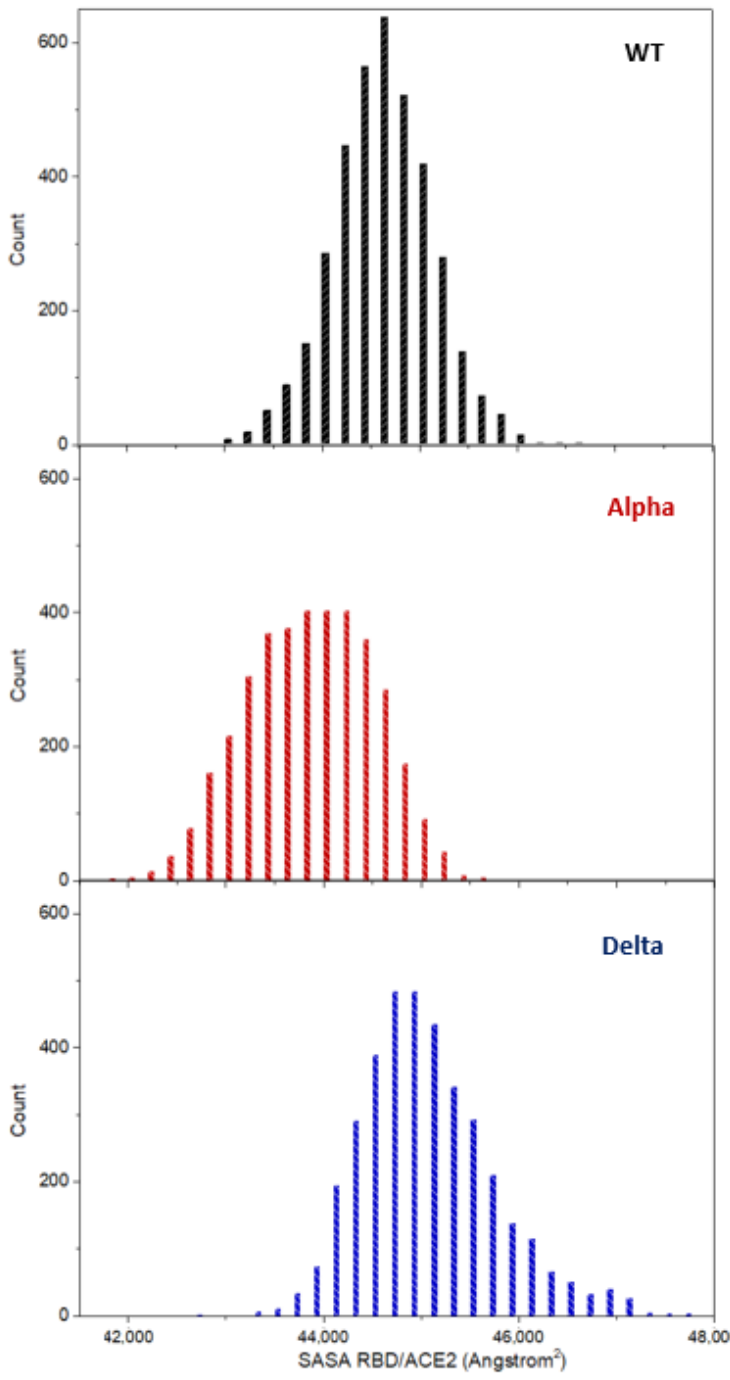
Figure 4. Histogram of the SASA values computed along the simulation time. The data of the three runs of each ACE2/RBD complex under study has been considered to build each